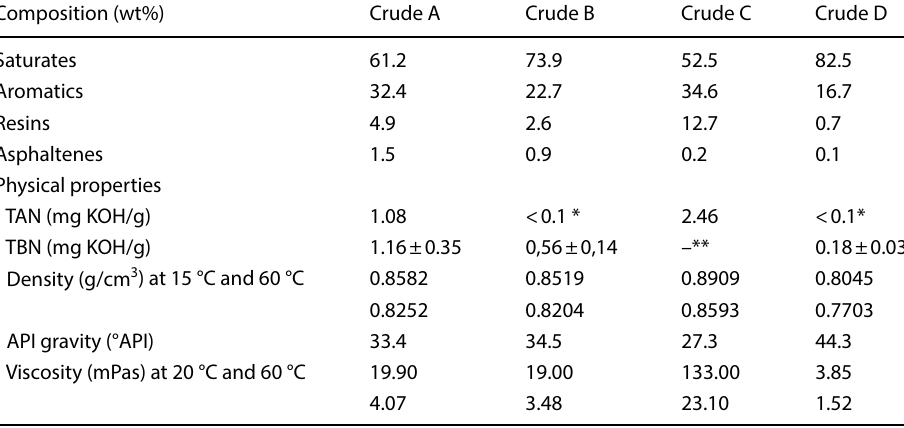
*Value below detection limit of the method **Not detectable because of resin precipitation on the